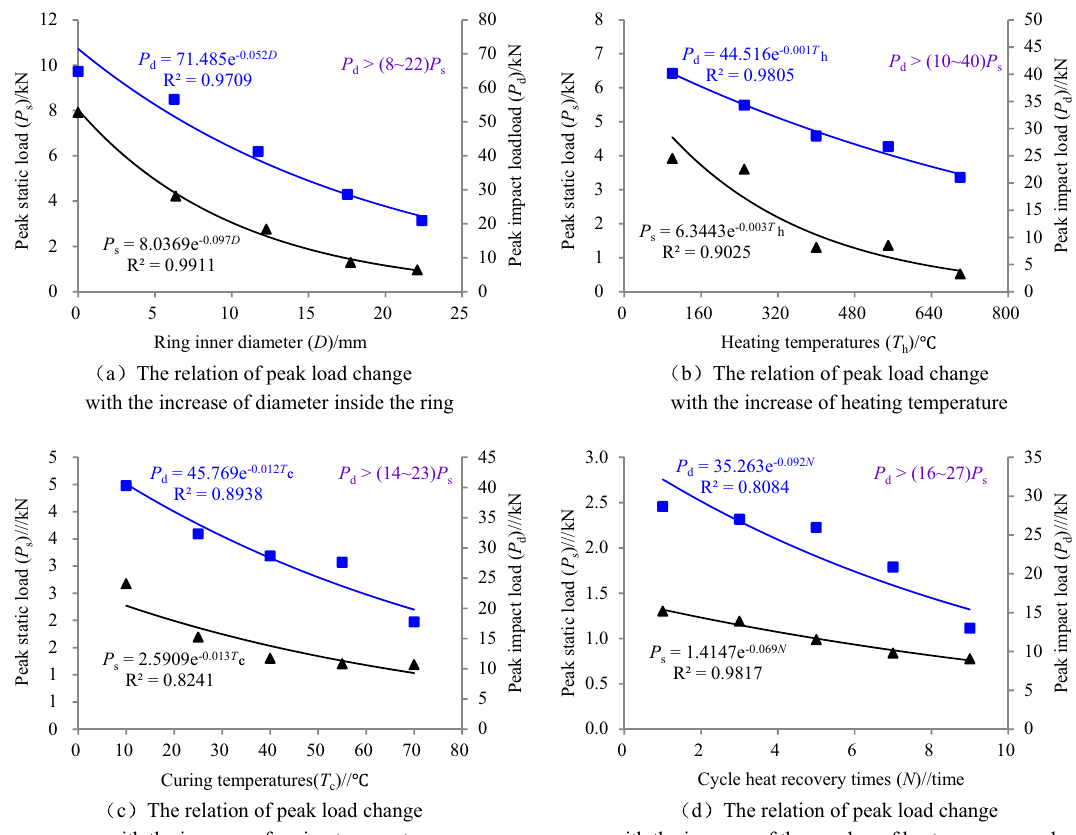
Figure 2. Relationship between peak load and ring inner diameter, heating temperature, curing water temperature and times of heat production cycle (The inner diameter of the rock samples are all about 18 mm in ( b – d